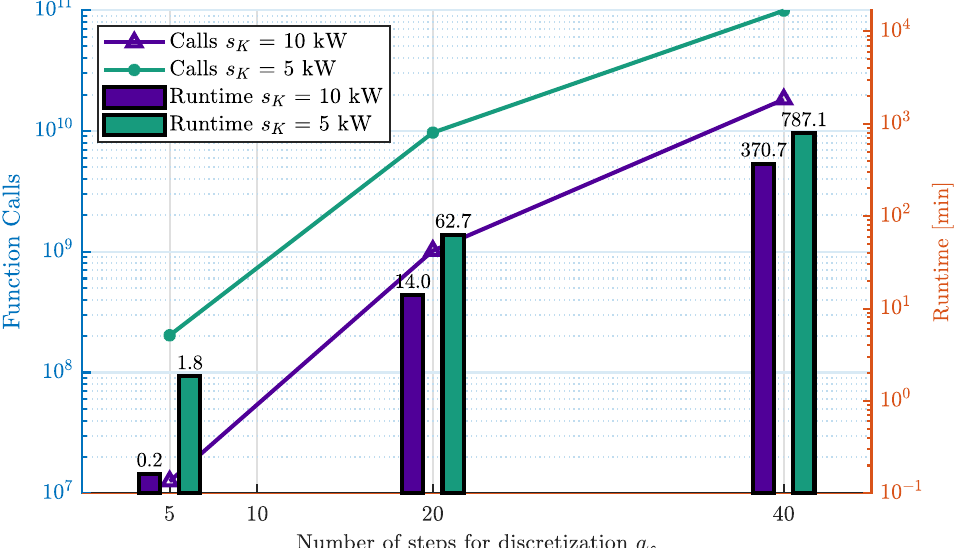
Figure 6. Runtime of OptTopo for different numbers of discretization steps q ϕ : With a finer discretiza- tion, the runtime grows slower than